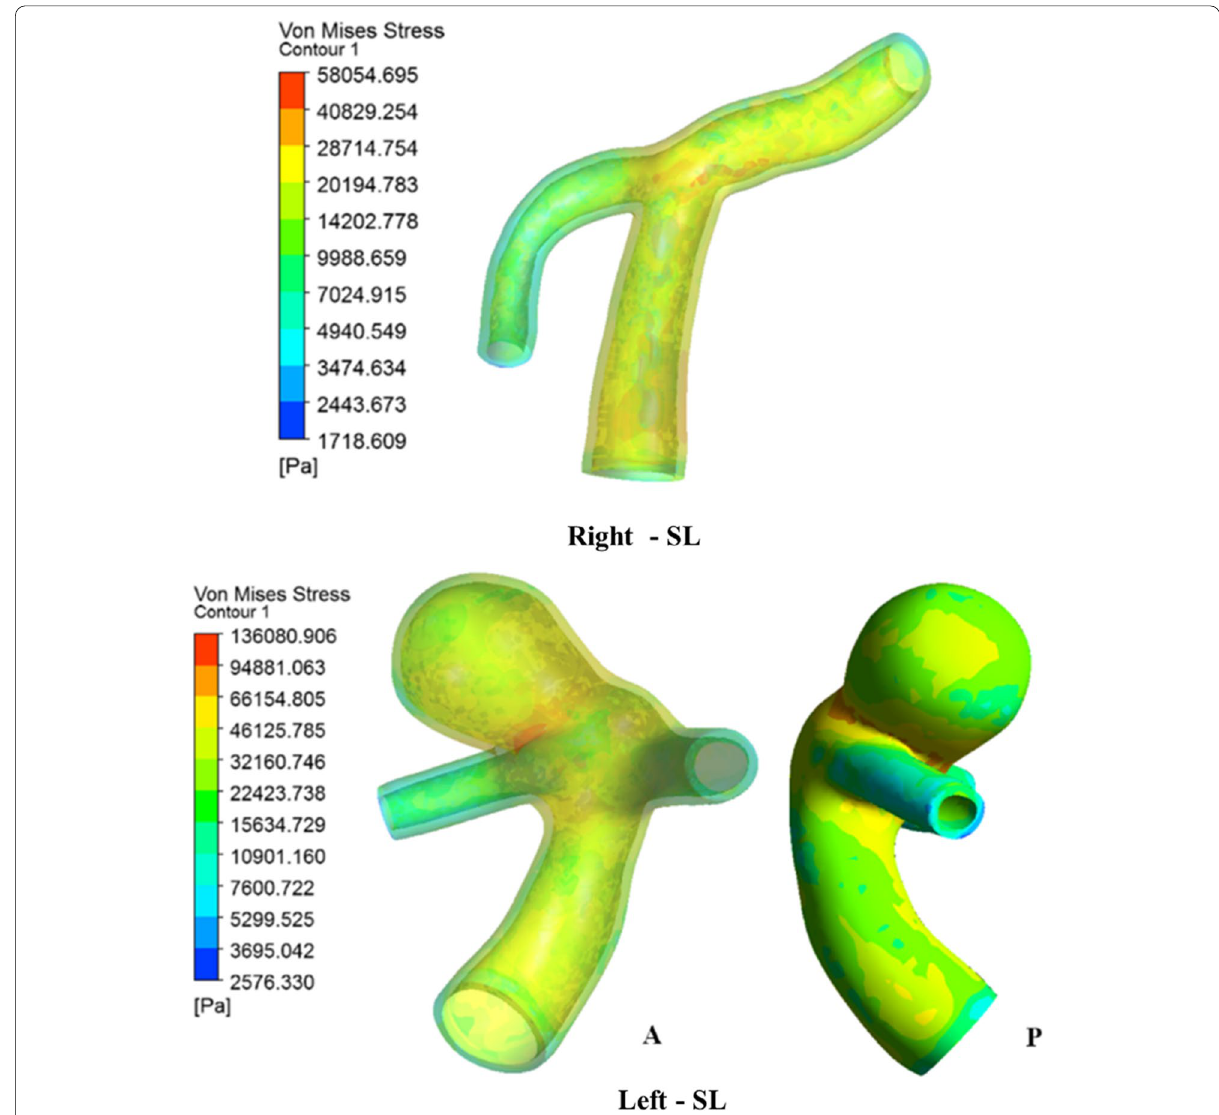
Fig. 14 Comparison of von Mises stress contours during peak